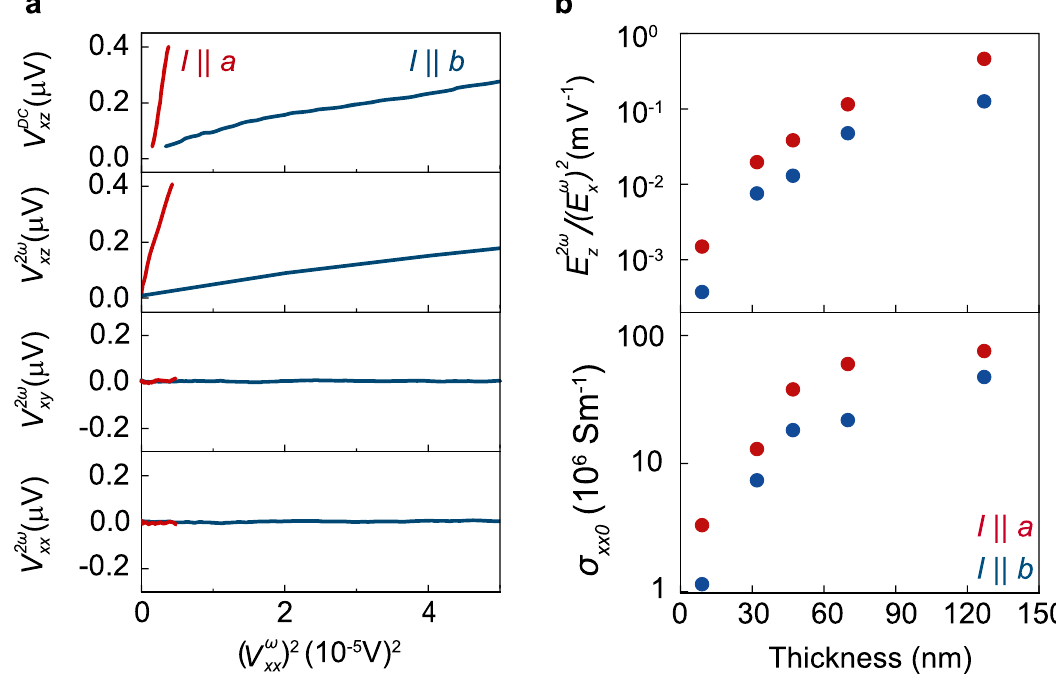
Fig. 2 Dependence of NLAHE on crystal axis and thickness. a Upper panels: DC and second harmonic V xz vs. fi rst harmonic V 2 xx for I k a and I k b in 127-nm-thick sample at 2 K. Lower panels: analogous second harmonic measurements for in-plane response show signi fi cantly weaker signal under (cid:4) (cid:5) 2 and residual longitudinal conductivity σ I k a and I k b . Both values are larger for comparable bias. b NLAHE strength E 2 ω z = E ω x xx 0 vs. sample thickness for greater thickness and I k a